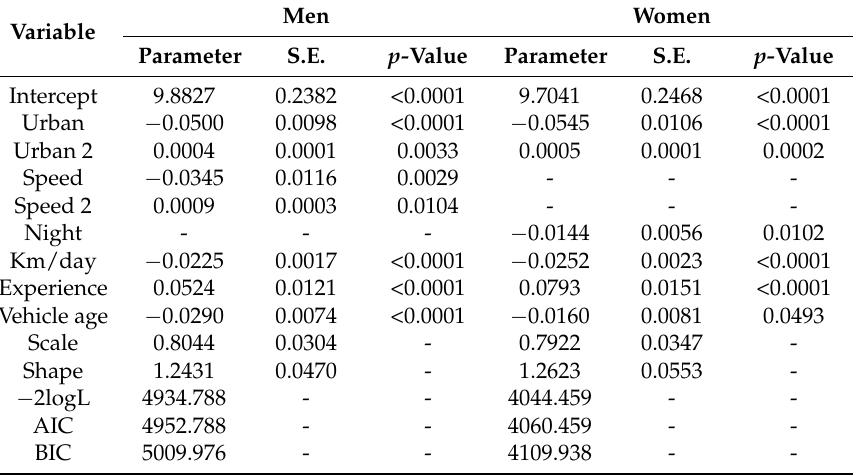
Table 4. Weibull model estimates of the time to the first accident for men and women drivers.